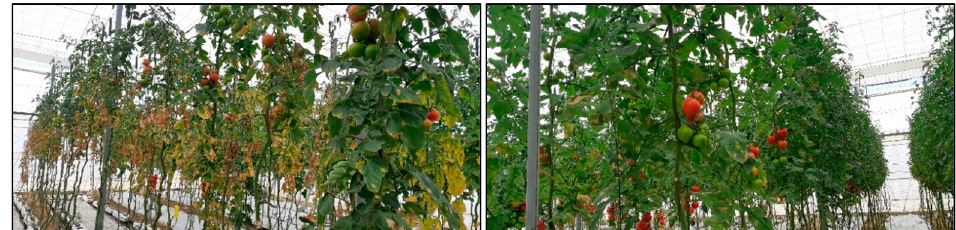
Figure 7. Difference in vigor between plants in coconut fiber substrate ( left ) and those in “ enarenado ” soil ( right ) for treatment T2 at 23 February 2021. soil ( right ) for treatment T2 at 23 February